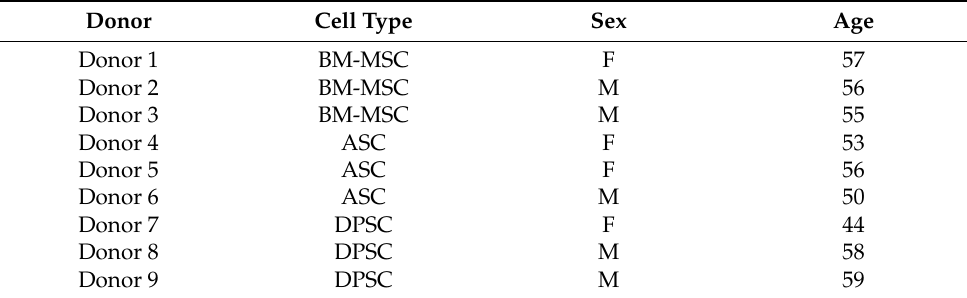
Table 1. Main characteristics of healthy